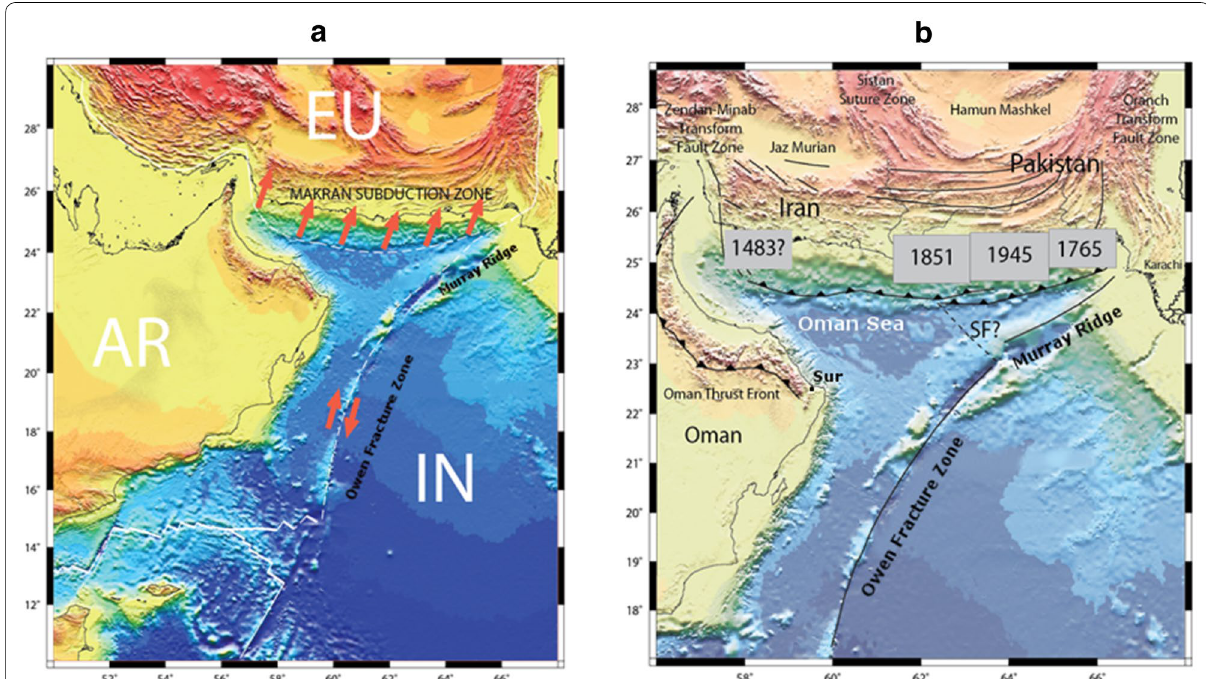
Fig. 1 a The tectonic framework of the Sea of Oman is constrained by the relative motion between the Arabian, Eurasian and India plates. The Arabian plate subducts underneath the Eurasian plate at a rate close to 2 cm/year while the relative motion between India and Arabia along the Owen strike slip boundary reaches 3.7 mm/year. b Ruptured area of strong earthquakes in Makran based on Byrne et al. (1992) and Zarifi (2006). SF: Sonne Fault, defining a small microplate, called Ormara microplate by Kukowski et al.